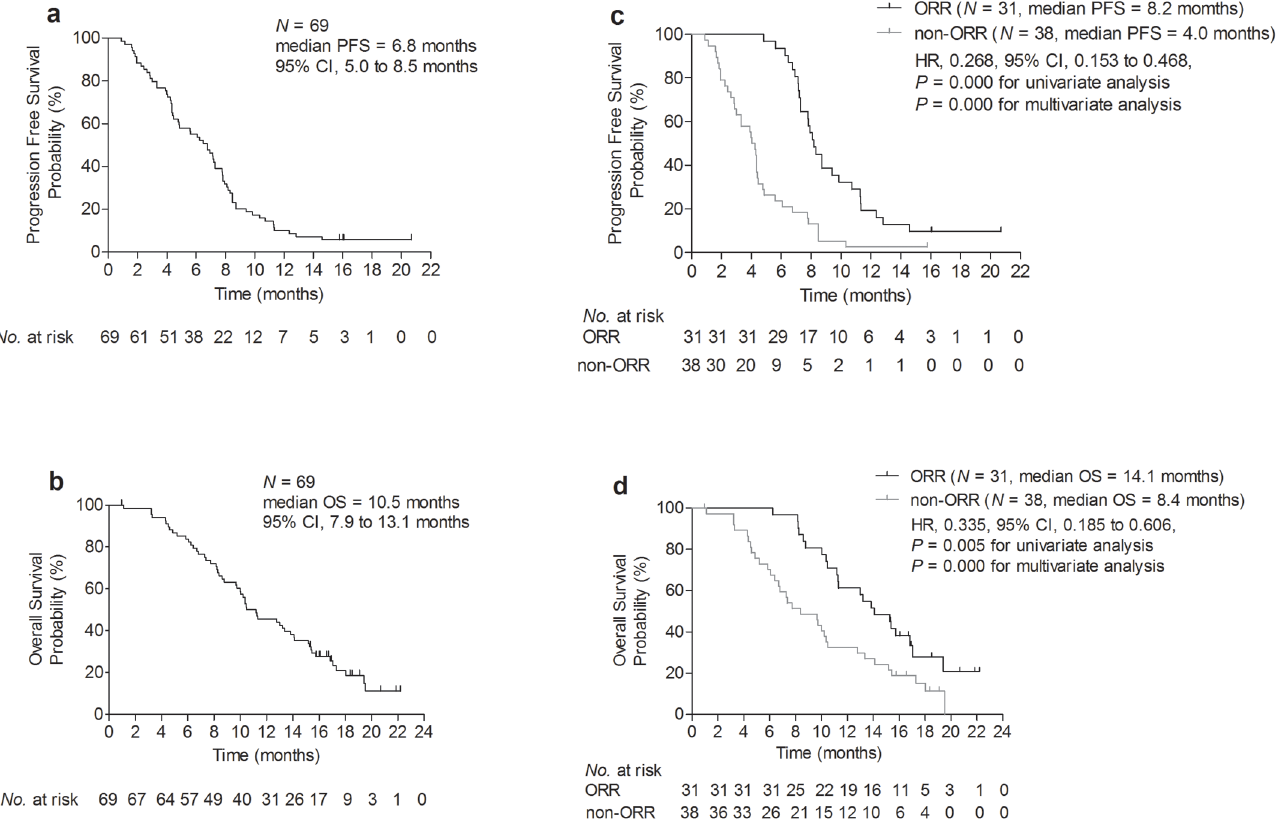
Fig 2. Kaplan – Meier plot of PFS (a) and OS (b) for all patients and Kaplan-Meier plot of PFS (c) and OS (d) in patients with ORR versus non-ORR.